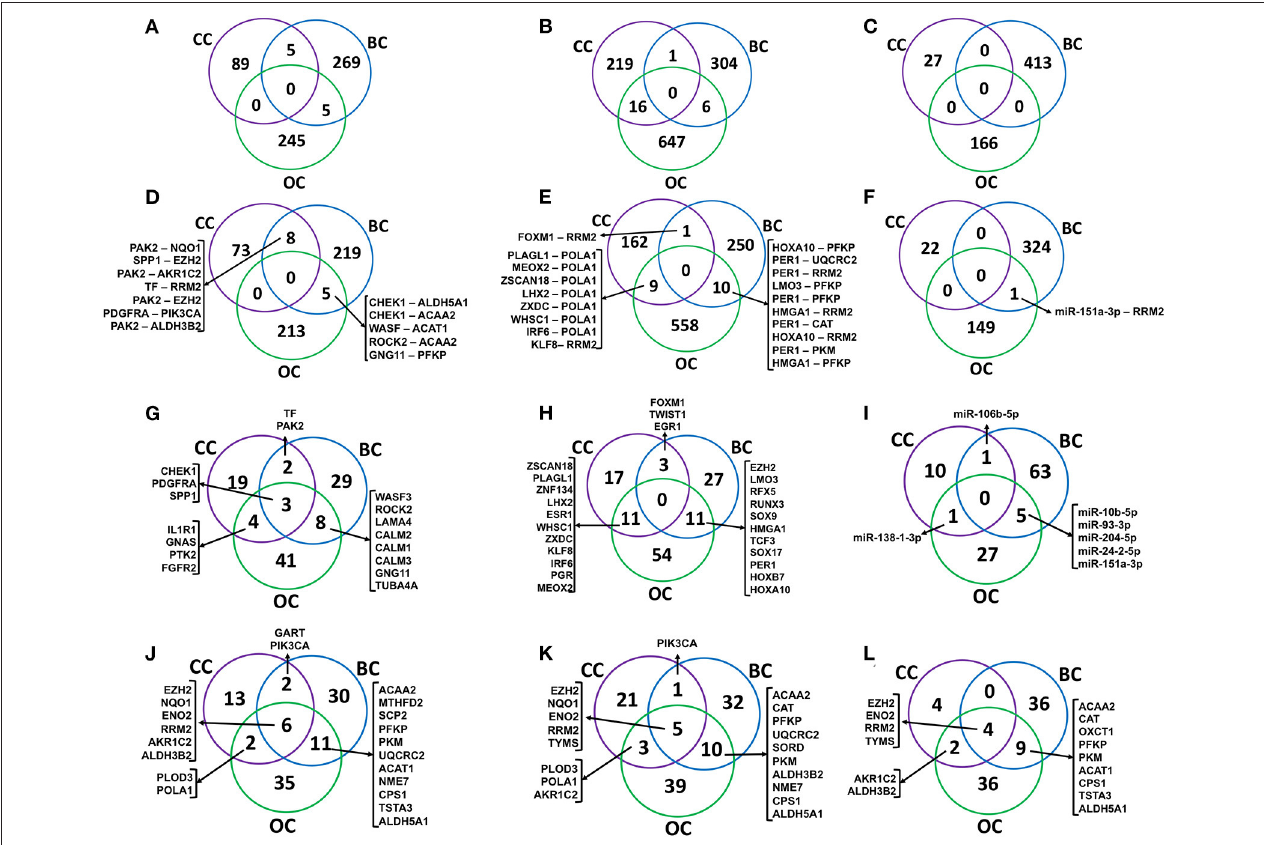
FIGURE 8 | Comparison of regulatory molecules and links in female-specific cancer. (A–C) show the overlap of significant signaling proteins (S), transcription factor (TF), and miR to metabolic enzyme connecting paths, respectively, identified from cervical cancer (CC), breast cancer (BC), and ovarian cancer (OC) specific networks. (D–F) show the overlap of S-M, TF-M, and miR-M pairs, respectively. (G–I) represent the overlap of terminal signaling protein in S–M paths, a transcription factor in TF–M paths, and miR–M paths, respectively. (J–L) represent an overlap of terminal metabolic enzymes. S-M, signaling-metabolic; TF-M, TF-metabolic; miR-M,